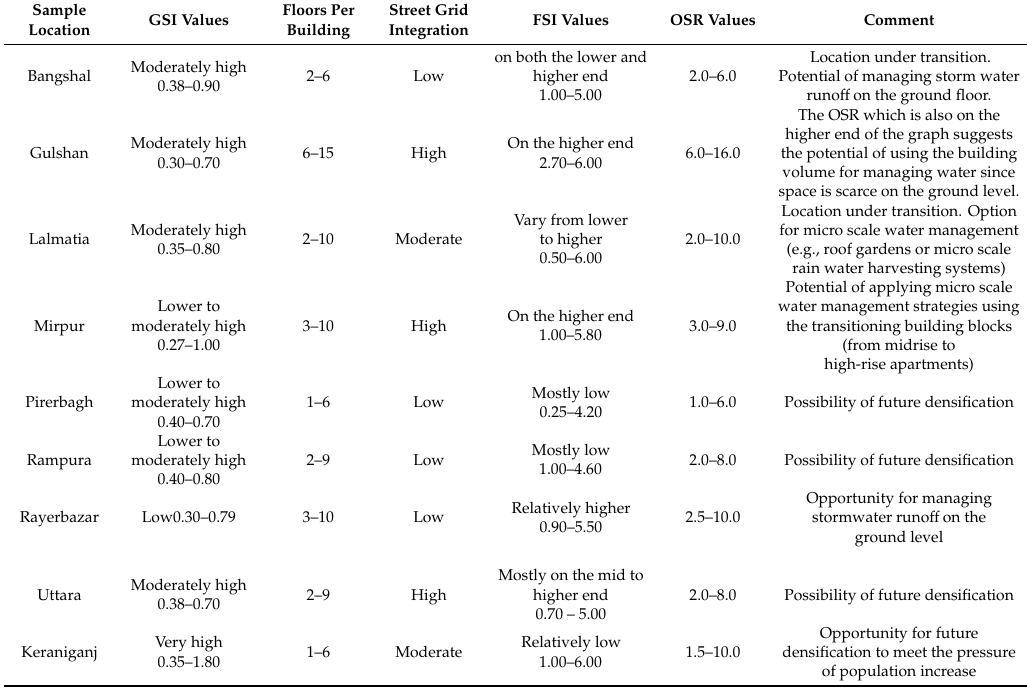
Table 1. Morphological analysis results of nine selected areas in